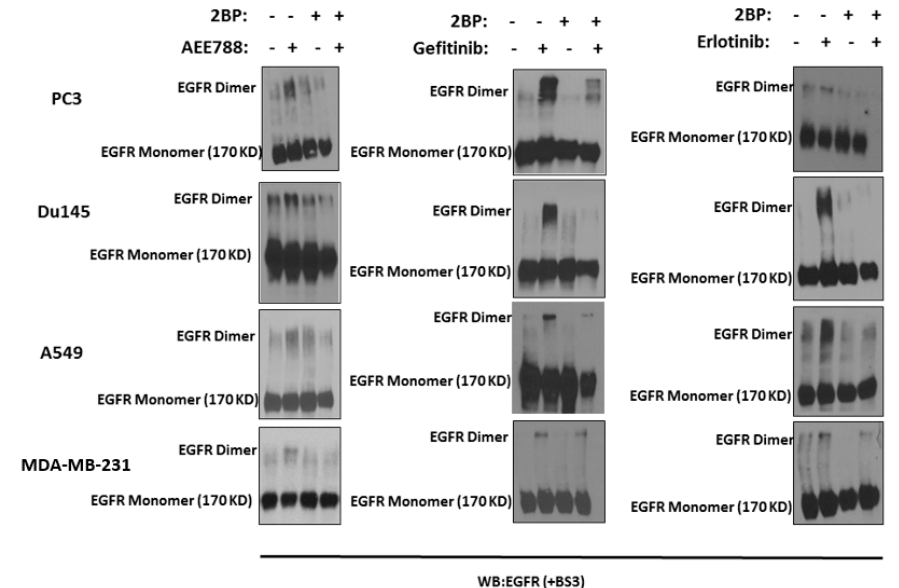
Figure 3. Inhibition of palmitoylation blocks TKI-induced EGFR dimerization. Cells were pretreated with 2-bromopalmitate (2-BP) at a concentration of 4 µM for 6 h in serum-free media. Following pretreatment, fresh media was added and the cells were treated with respective TKIs (AEE788. gefitinib, and erlotinib) at a final concentration of 5 µM for 24 h. The degree of EGFR dimerization were analyzed following membrane crosslinking using BS3. The cell lysates were resolved on SDS-PAGE gel in reducing conditions followed by Western blot.